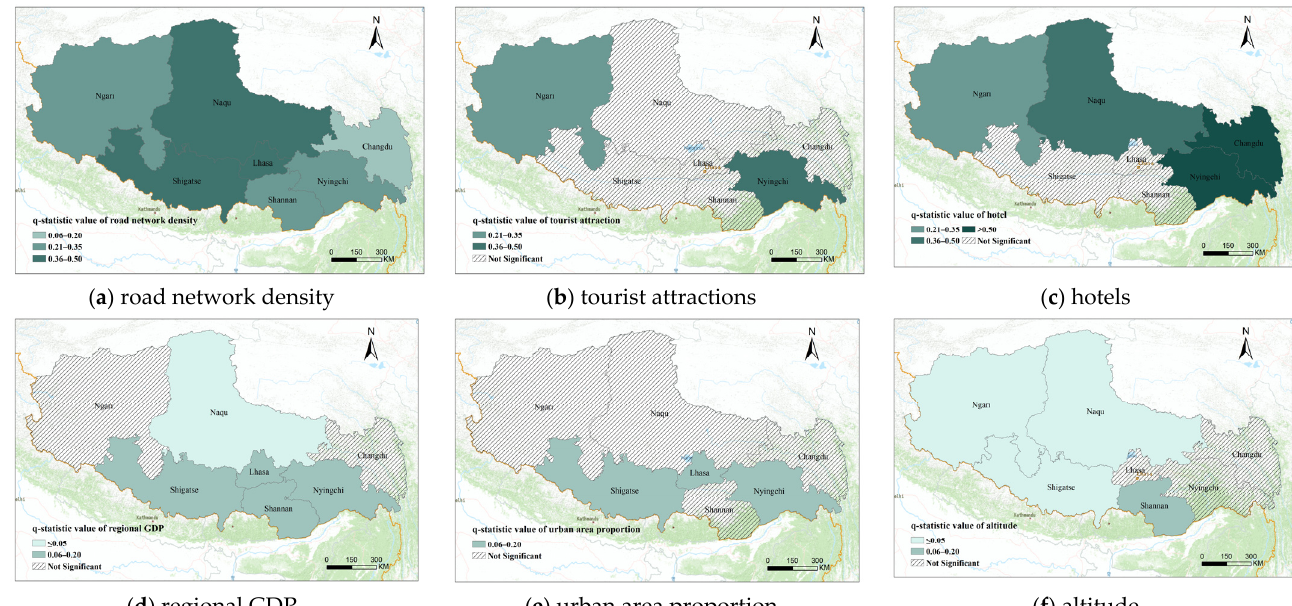
Figure 9. q - statistics of factor interceptions by city in Qinghai Figure 9. q -Statistics of factor interceptions by city in Qinghai. Table 5. Point data statistics of cities in Qinghai and Tibet (2017).